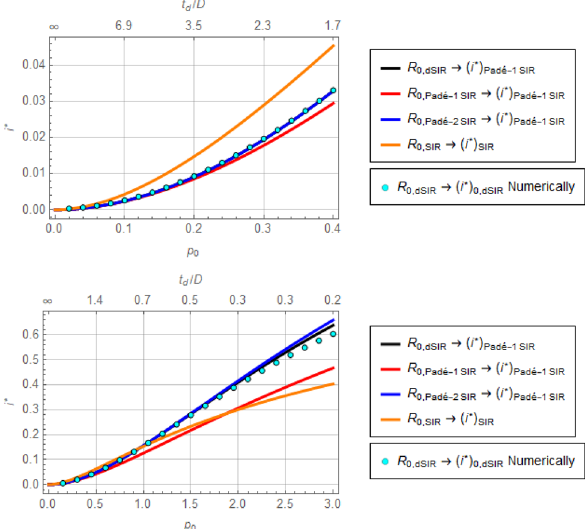
Figure 7. Predicted maximum infectious fraction, i ∗ , based on the exponential rate, p 0 , of an epidemic spread. The values of i ∗ are calculated by ( a ) the analytical expression of the Pade-1 SIR model fed with estimates of R 0 from p 0 according to the dSIR, Pade-1 SIR, and Pade-2 SIR models, ( b ) the analytical expression of the standard SIR model fed with an estimate of R 0 from p 0 according to the same model, and ( c ) numerically by integration of the dSIR model fed with an estimate of R 0 from p 0 according to the same model. The top graph is portion of the bottom graph at higher